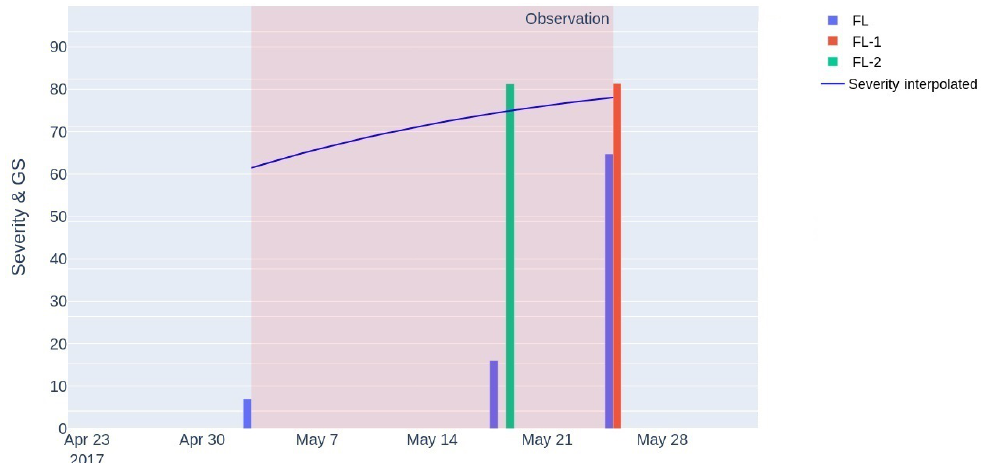
Figure 4. An extension of Figure 3 which represents the leaf level yellow rust severity values collected on field trials. FL represents the flag leaf level, or the top most leaf of the canopy and the subsequent labels represents the leaf below the flag leaf, i.e., FL-1 represents 1 level below the flag leaf level, and so